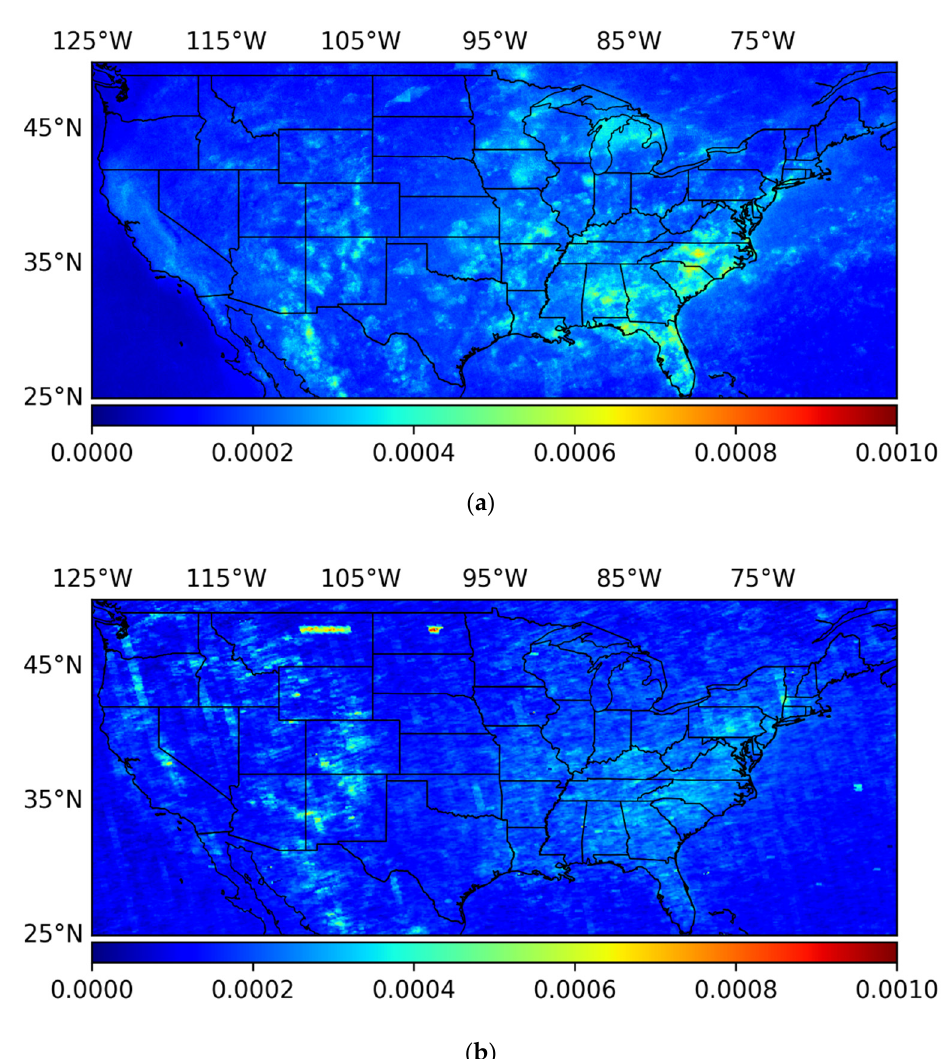
Figure 15. ( a ) Average HCHO VCD over the U.S. in July 2019, derived from Sentinel-5P data; ( b ) Average HCHO VCD over the U.S. in July 2019, derived from OMI data (unit: mol/m 2 ).